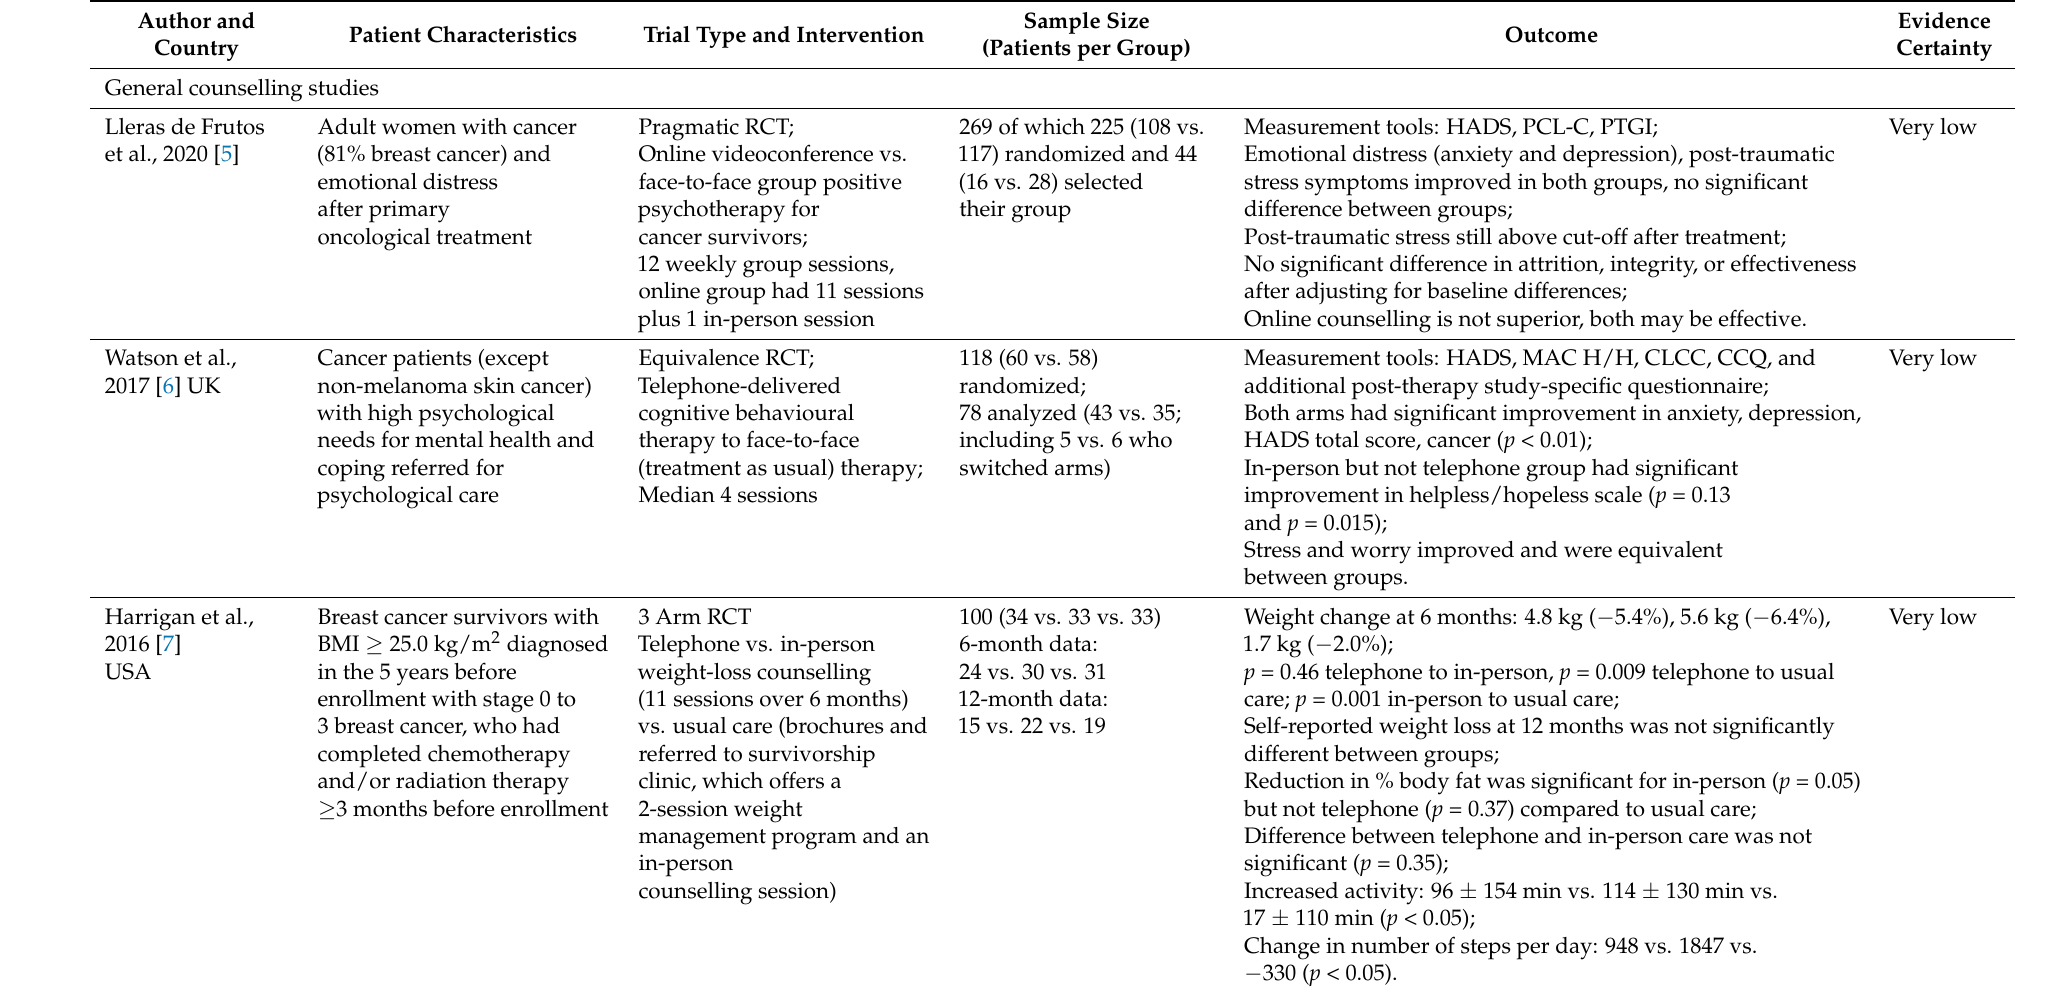
Table 1. General or genetic